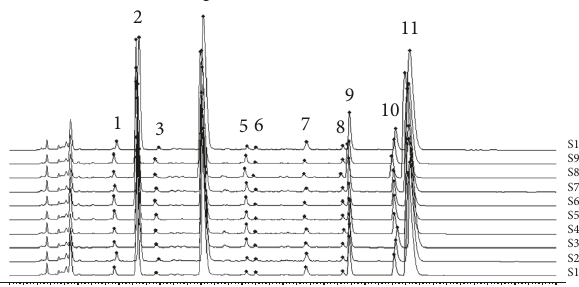
Figure 3: HPLC fingerprints of the ten batches of Berberidis